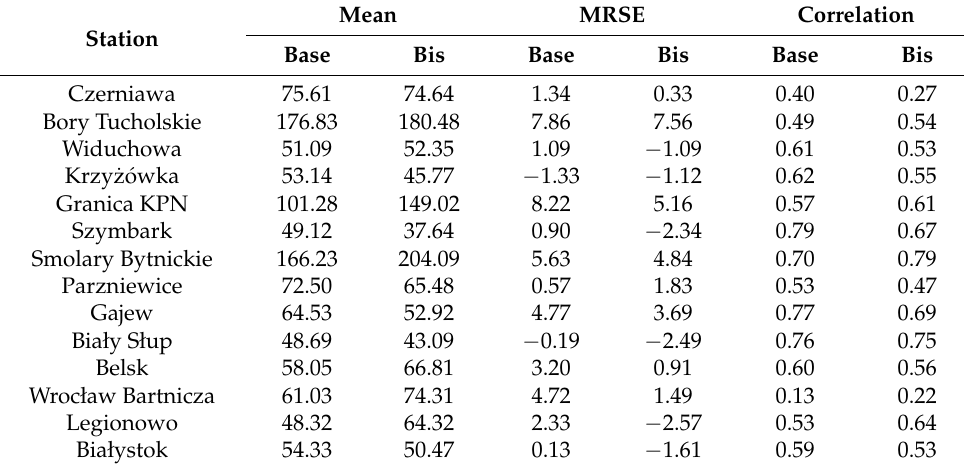
Table 9. Statistical measures for two scenarios (Base—with base emissions) and Bis (with modified emissions, using correction factors based on satellite data) calculated for 2011. Mean MRSE Correlation Station